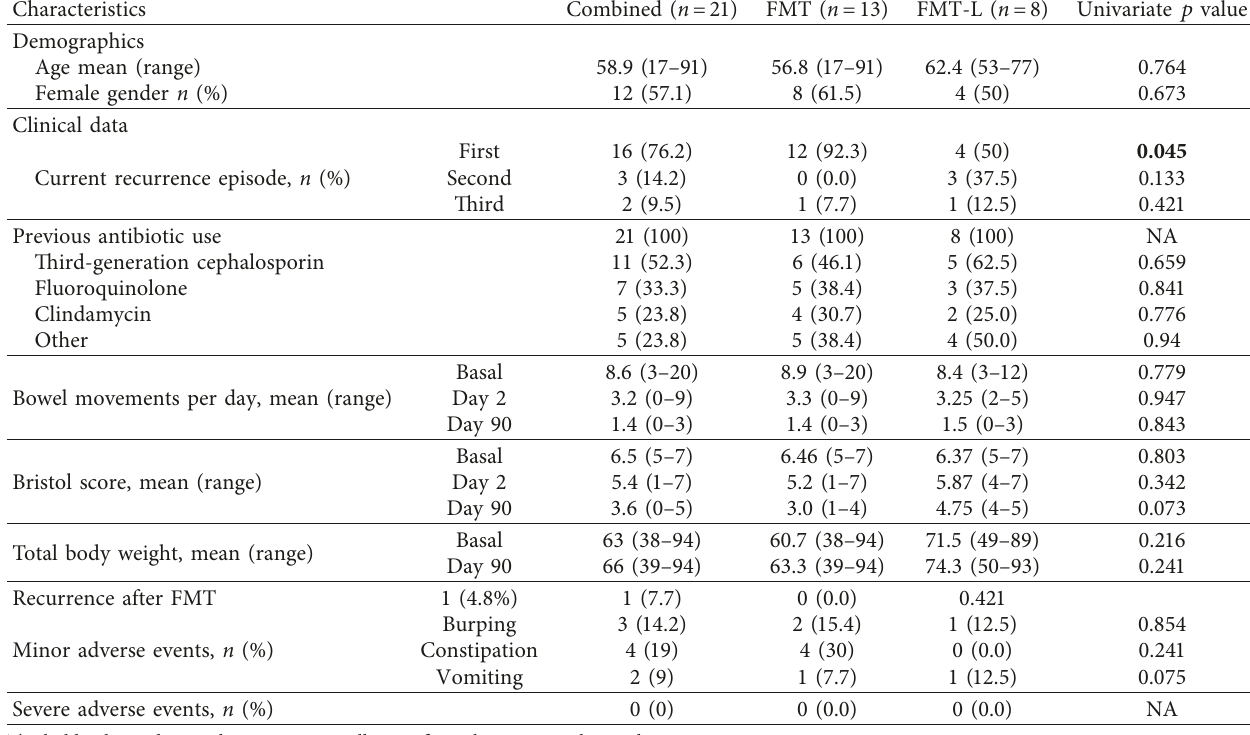
Table 1: Demographics, clinical, and treatment characteristics of both